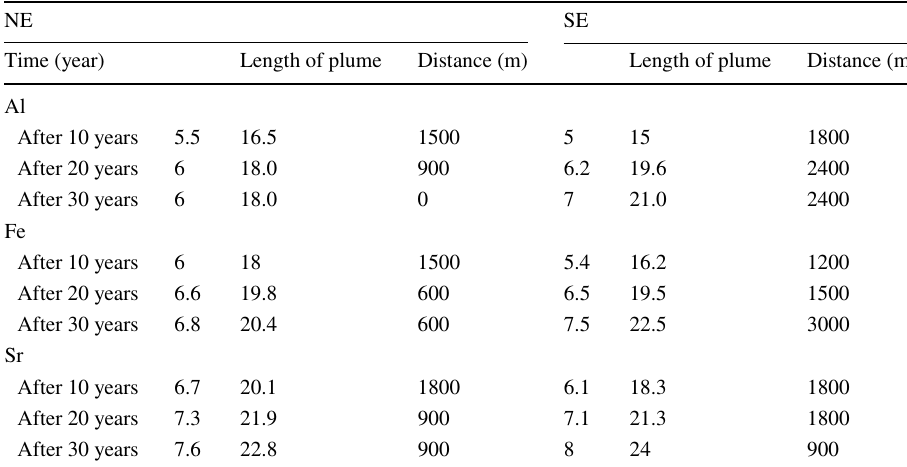
Table 12 Predicted transport distance of contaminant plume based on the results of MT3D